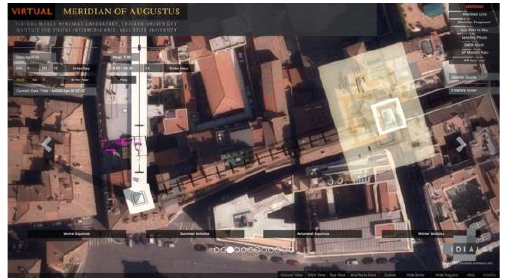
Figure 16: Location of the obelisk, the meridian line and the Ara Pacis in today's urban landscape